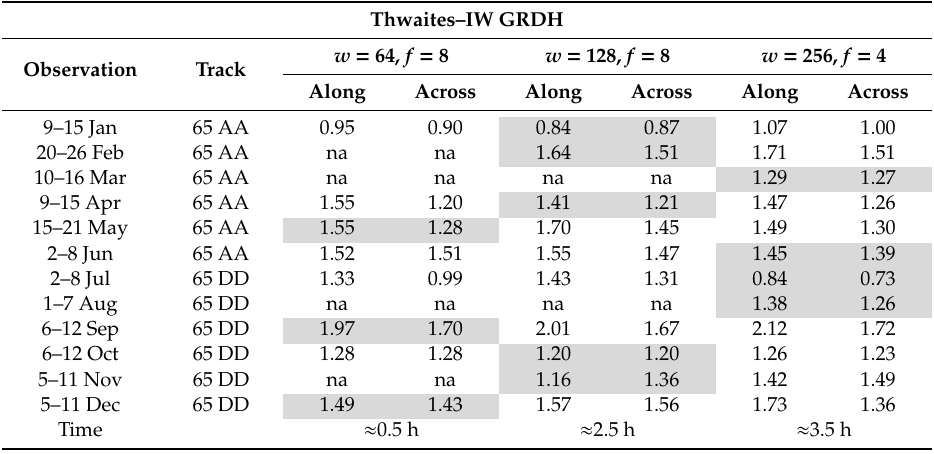
Table 11. THW, IW GRDH product class experiments, RMSE (expressed in m / day) with respect to available literature data measured along selected along / across flow